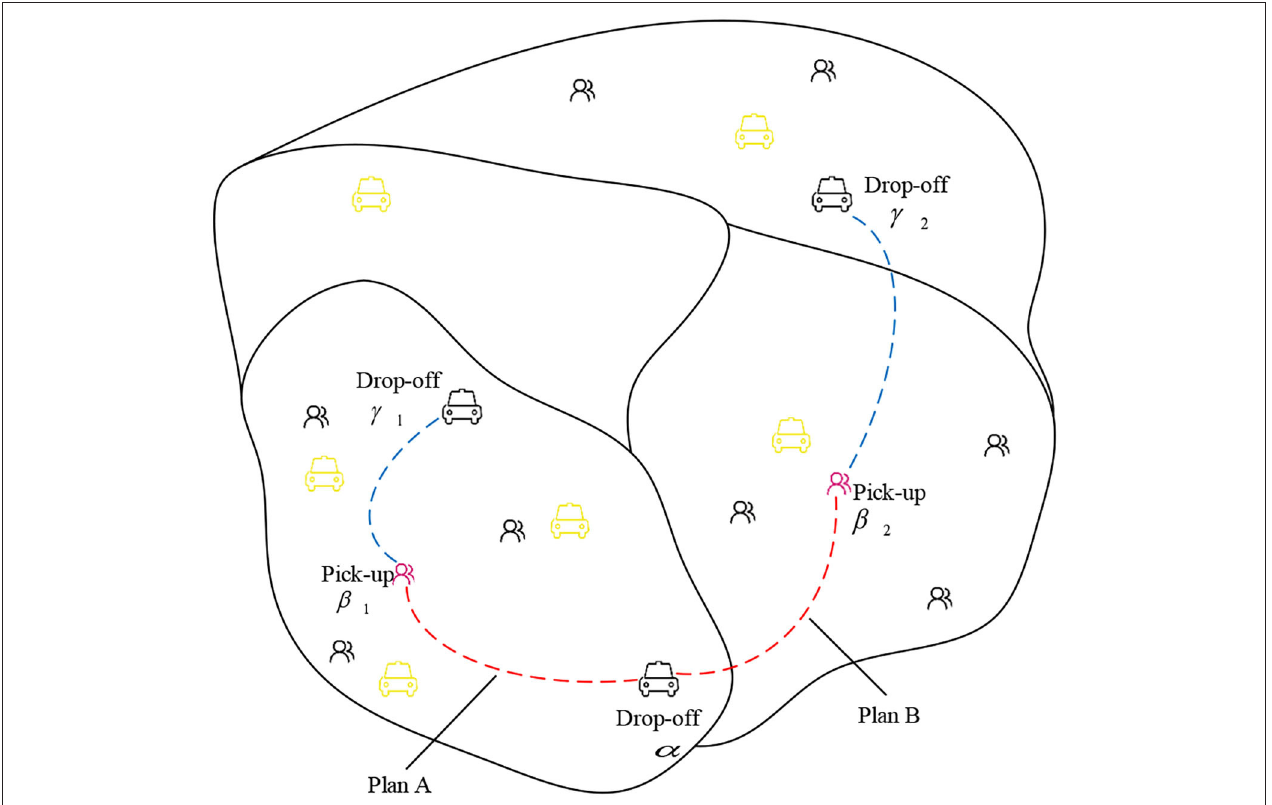
FIGURE 4 | A typical customer search and delivery process.